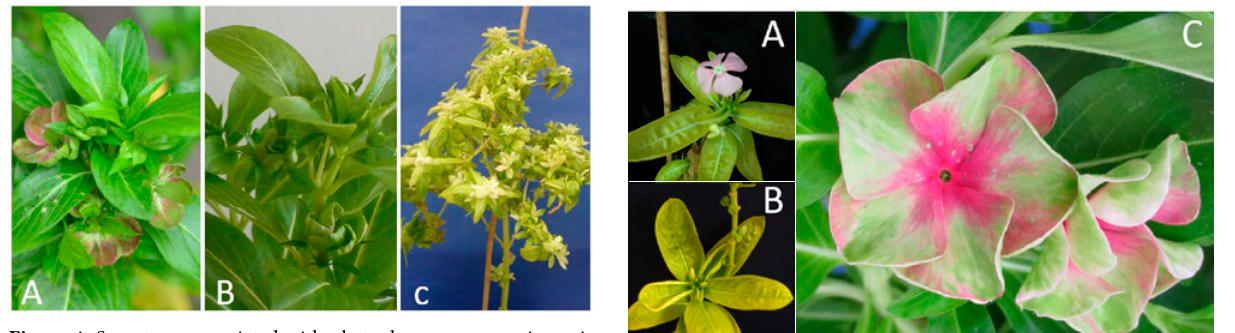
Figure 4. Symptoms associated with phytoplasma presence in peri- winkle after Paratanus exitiosus transmission. A) VC28C, flowers with virescence; B) VC31C, flowers with virescence and phyllody; C) VC33A, plant with witches’ broom, small and yellow leaves.